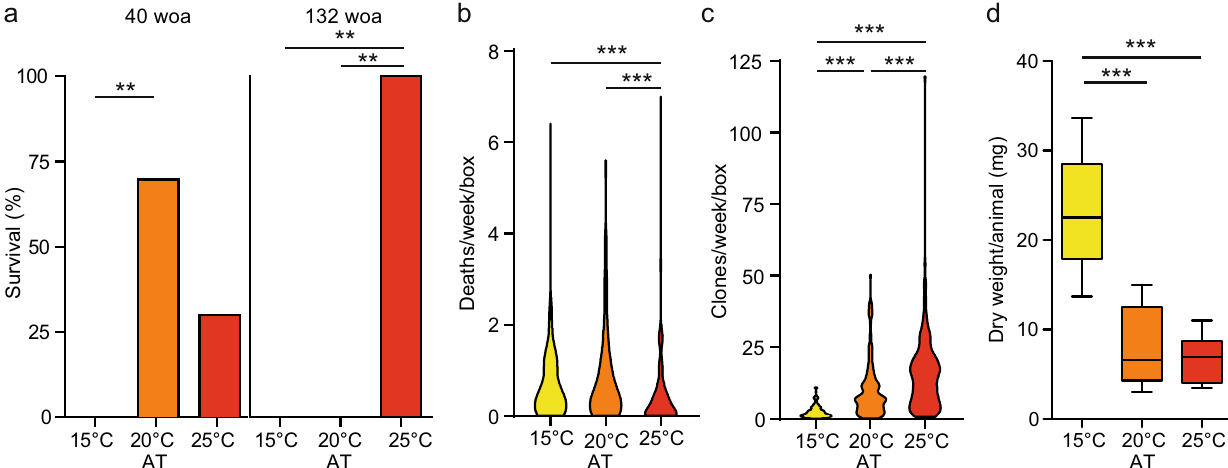
Fig. 2 Phenotypic plasticity in response to thermal acclimation. a Survival of acclimated polyps after heat stress (40 °C, 6 h). Statistical analyses were performed by a Fisher ’ s exact test ( n = 10 (40 woa), ** p = 0.0031), n = 5 (132 woa, ** p = 0.0079). b Average of dead polyps per week per box throughout the whole acclimation period ( n = 5, 161 woa) (Kruskal – Wallis test followed by Dunn ’ s post hoc comparisons, H = 24.09, *** p < 0.001). c Average of clones generated per week per 50 animals throughout the whole acclimation period, n = 5, Kruskal – Wallis test followed by Dunn ’ s post hoc comparisons, H = 191.6, *** p < 0.001. d Dry weights of acclimated polyps at 161 woa, n = 10, Kruskal – Wallis test followed by Dunn ’ s post hoc comparisons, H = 19.01, *** p < 0.001. Box plots are presenting center line, median; box limits, upper and lower quartiles; whiskers, 1.5x interquartile acclimated at 20 °C clustering between the two extremes (15 °C signi fi cantly increase at high temperatures (one-way ANOVA, and 25 °C). This indicates that the three different ATs induced F = 17.27, p = 0.0004) ( Supplementary Table 1 ) , and Epsilonpro- differentiation of three distinct microbial communities since the teobacteria, which signi fi cantly increase at low temperature (one- beginning of the acclimation process and that this differentiation way ANOVA, F = 25.96, p < 0.0001) (Fig. 3c, Supplementary is more pronounced between the extreme ATs. While most Table 2). bacterial groups maintain a stable association with N. vectensis Using the Binary-Pearson distance matrix, we calculated the (Fig. 3c), bacteria that contribute to the differentiation at the end distances between samples within all three acclimation regimes of the acclimation process are Alphaproteobacteria, which (Fig. 3d) and sampling time points (Fig. 3e). Continuous